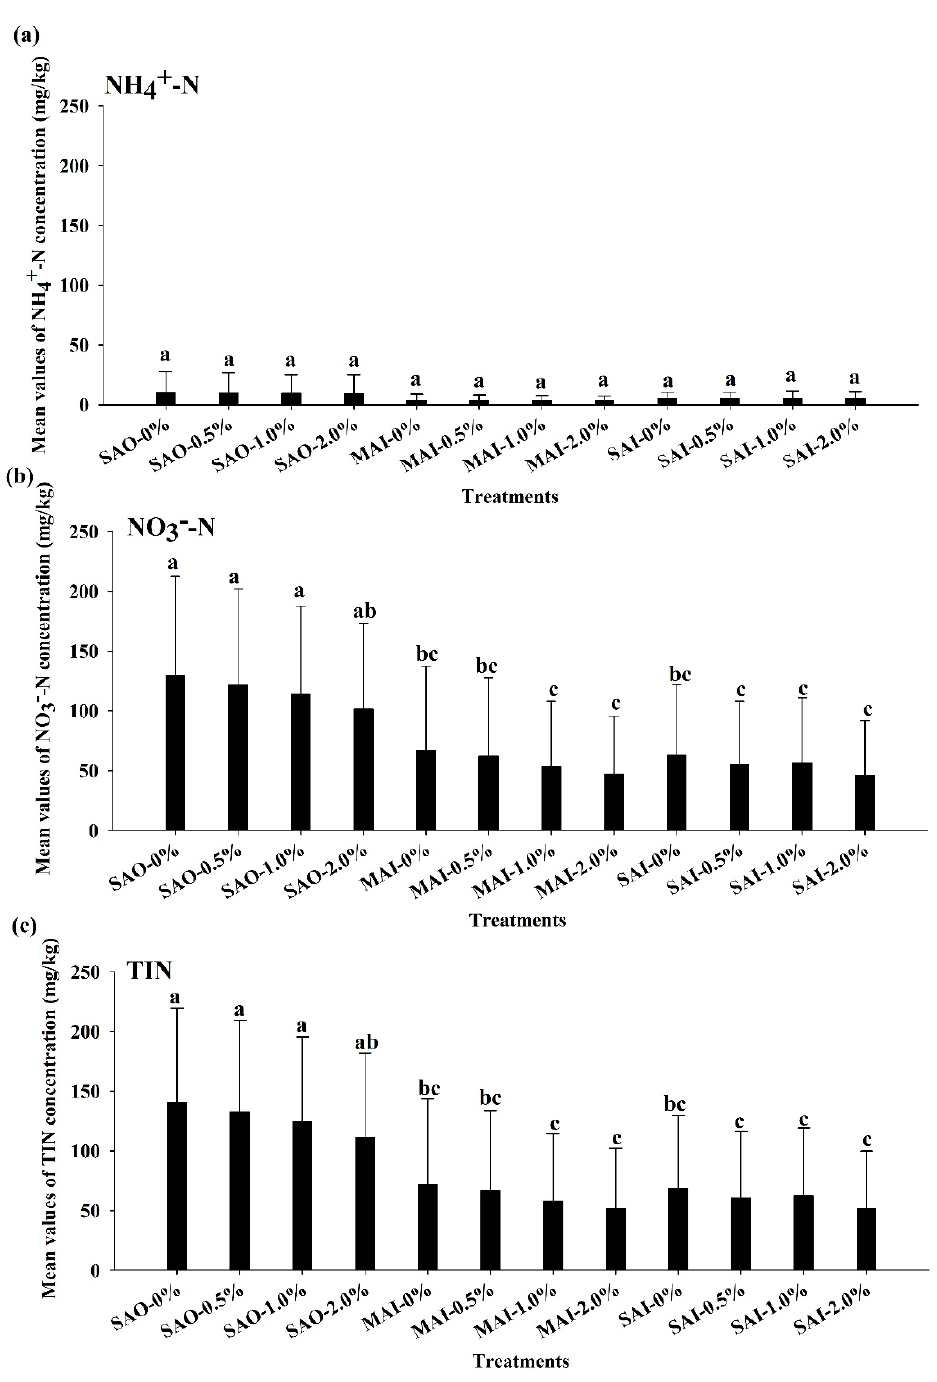
Figure 3. Mean values (mg/kg) of (a) NH 4+ -N, (b) NO 3− -N, and (c) total inorganic N (TIN) in three studied soils during a 371-day incubation. The different lowercase letters indicate the significantly difference at p < 0.05 between treatments. The data are mean value ( n = 110), and vertical bars represent standard deviations (SDs) of the means).